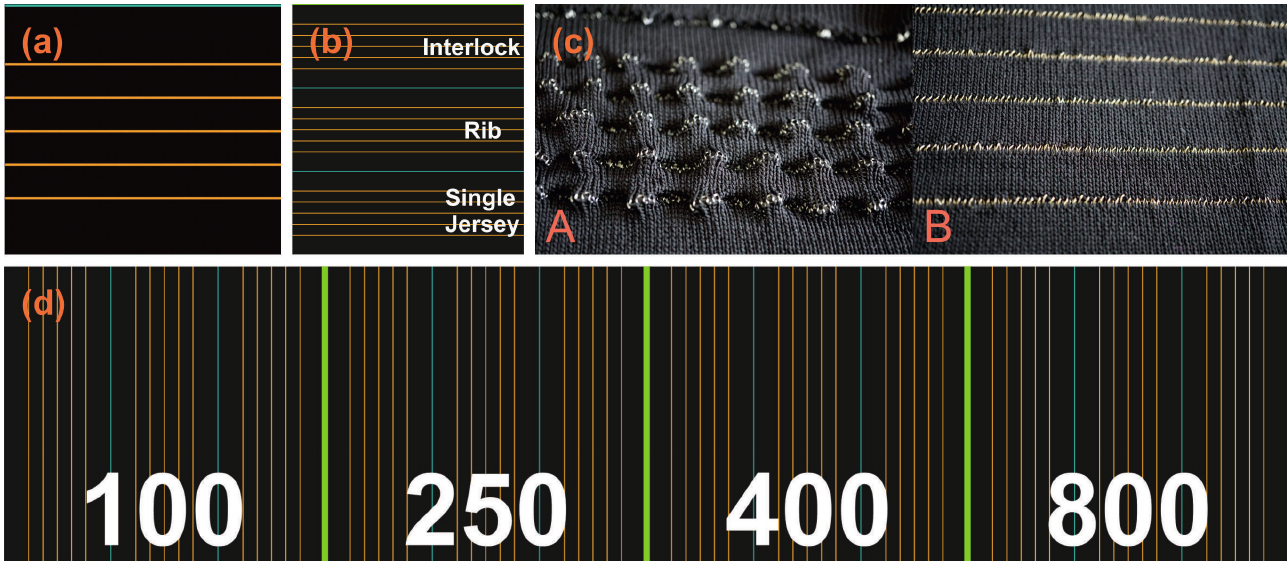
Figure 5. Knit structure, knitting speed and yarn segments. ( a ) Schematic representation of a knit structure segment; ( b ) Schematic representation of a speed segment with knit structure segments; ( c ) Buckling in SJ test specimen: A STEEL, B MDR40; ( d ) Schematic representation of a yarn segment with speed